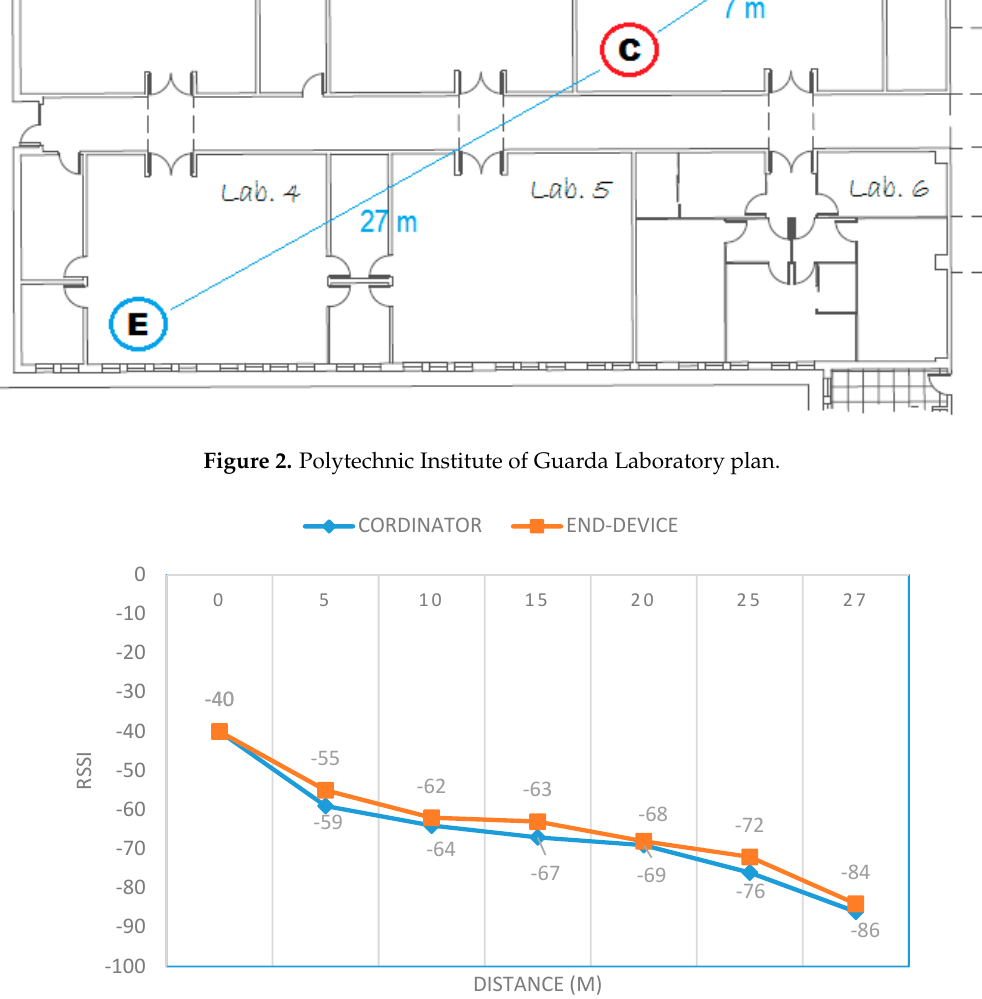
Figure 3. Relation between distance and RSSI.